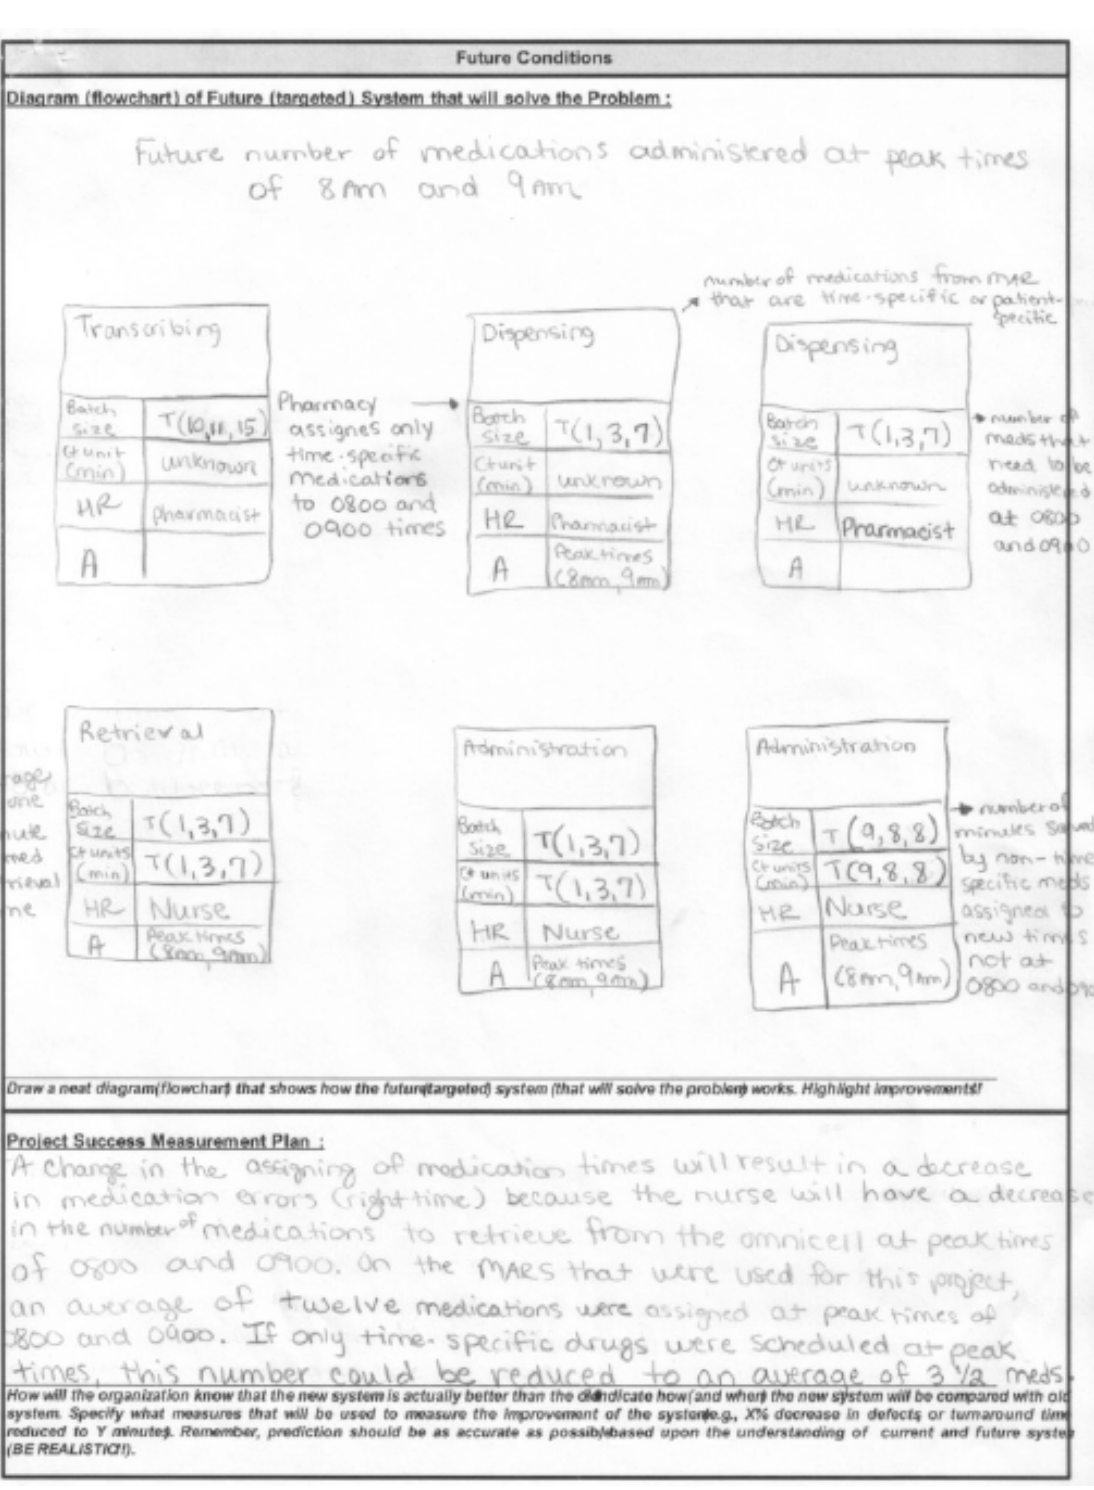
Figure 3c. “Example of Completed Map to Improve